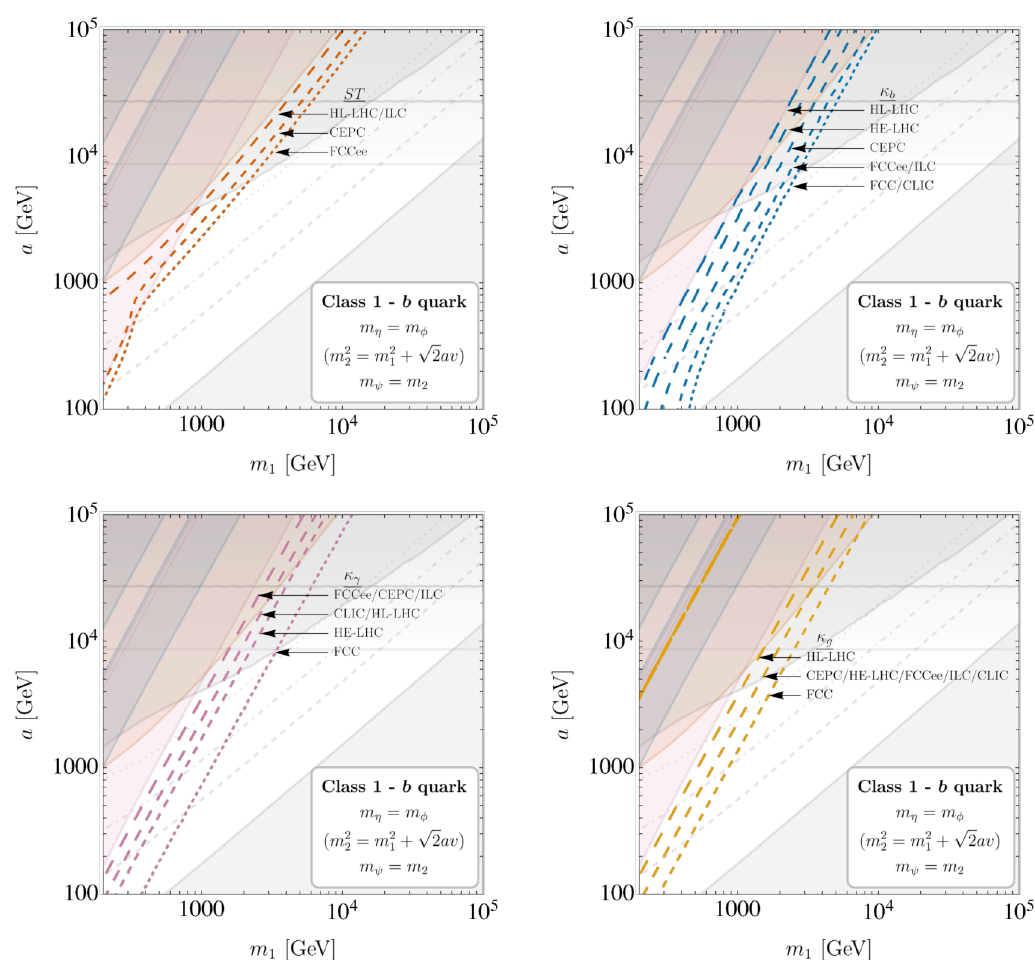
Figure 6. Projected 2 σ experimental sensitivities on the Class 1 b -quark benchmark model at future colliders for the left hand slice in fig.